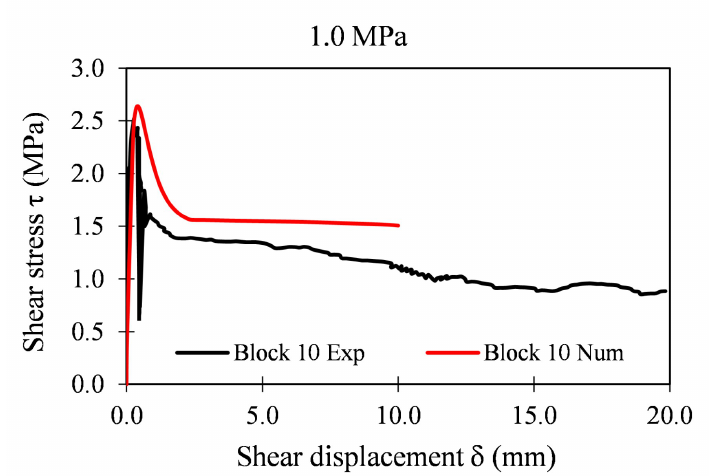
Figure 31. Shear stress evolution with displacement Exp–Num (Block 10).